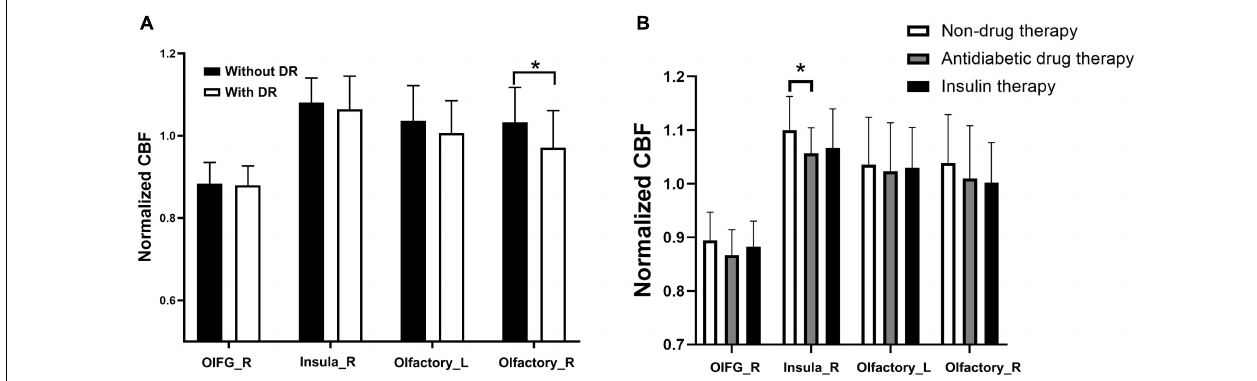
Olfactory cortex